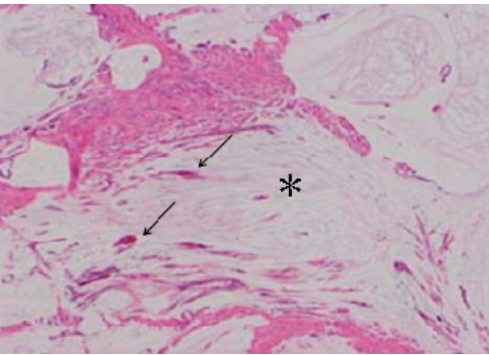
Figure 7. Histologic finding of peritoneal metastasis from appendiceal mucinous neoplasm (Figure 7). Mucinous materials (*) produced from cancer cells ( → ) extensively occupied stromal tissue.